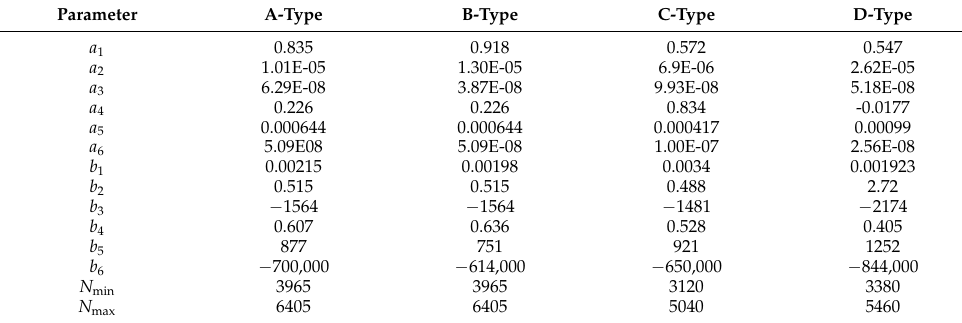
Table 5. Parameters of the four types of